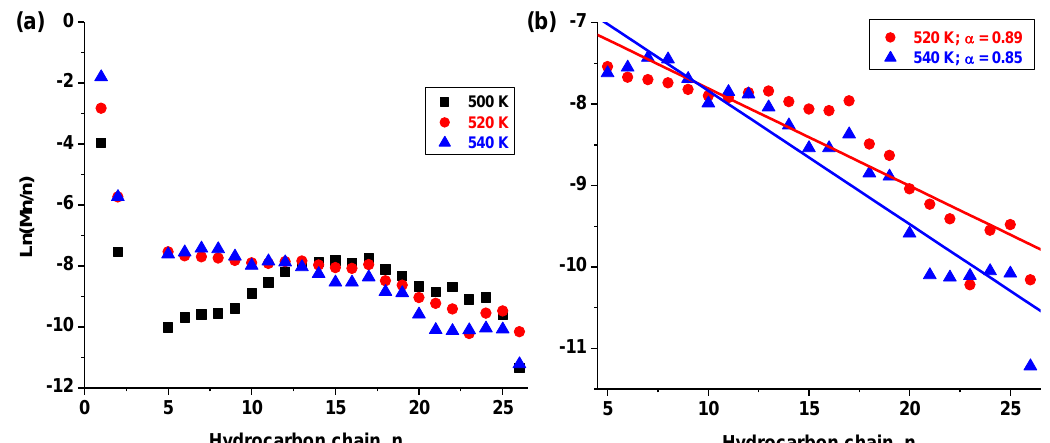
Figure 8. Modeling the ASF kinetics from selectivity data of the Co/C sample ( a ) at 500, 520, and 540 K, and ( b ) at 520 and 540 K.